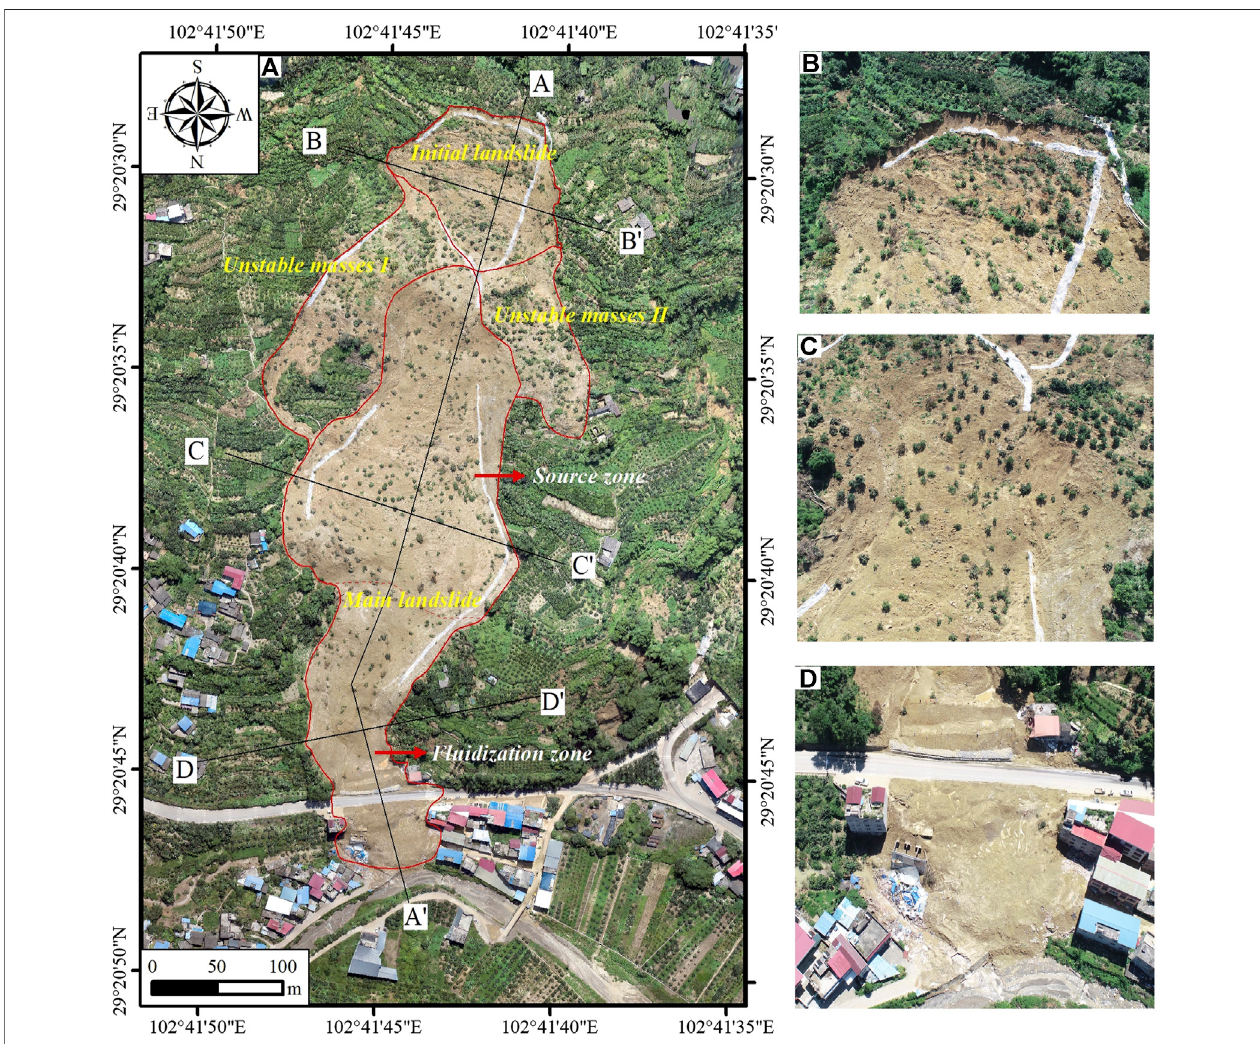
FIGURE3|(A) Thelandslideboundaryandpartitionbasedon fi eldinvestigation andUAVimage. (B) Theupper scarpoftheinitiallandslide. (C) Theupperscarpof the main landslide. (D) The front edge of the main landslide.